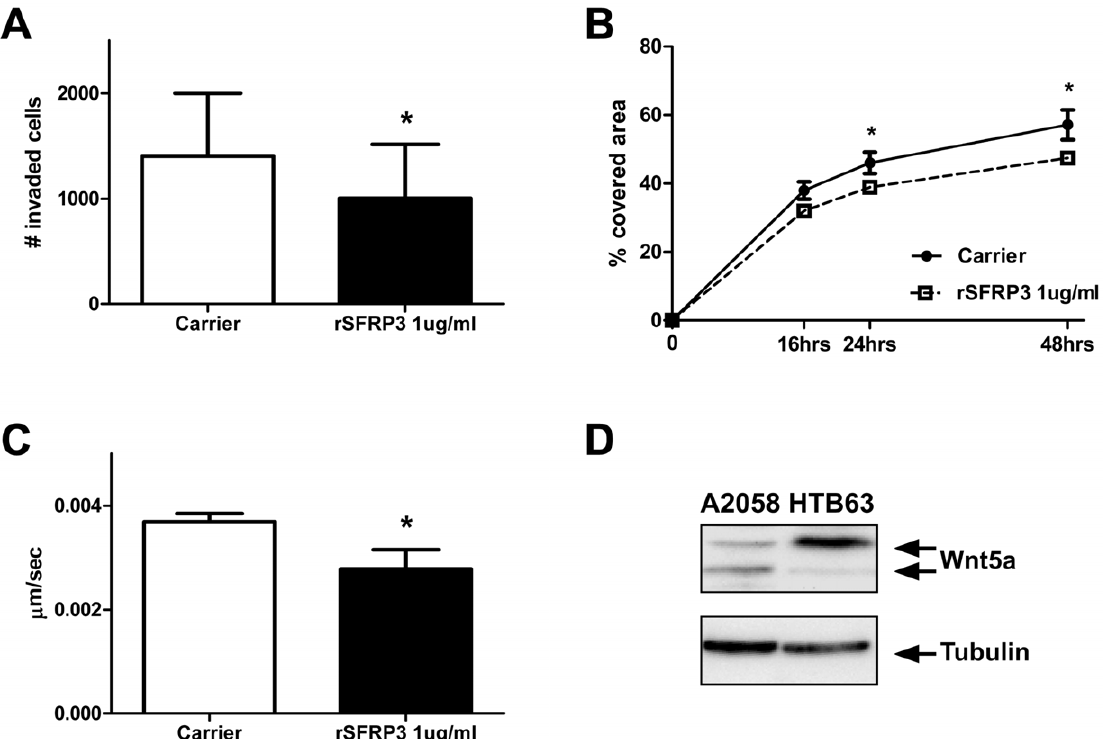
Figure 3. Recombinant SFRP3 decreases migration and invasion of melanoma cells. A , Invasion assay using Matrigel invasion chambers. A2058 cells were resuspended in serum free media and treated in the upper chamber with 1 m g/ml of rSFRP3 or carrier (0.1% BSA in PBS) and allowed to invade for 24 h. The error bars represent SEM, (n=5). B , Wound healing assay. A2058 cells were treated with either 1 m g/ml of rSFRP3 (dashed line, squares) or carrier (full line, circles). Pictures were taken of the scratches at 0, 16, 24 and 48 h. Data is given as percentage of wound area closed at each time point. The error bars represent SEM, (n=5). C , Migration assay, A2058 cells were treated with either 1 m g/ml of rSFRP3 or carrier in serum- free media and migration of non-dividing individual cells was analyzed manually by tracking the speed of cells for 12 h. The error bars represent SEM, (n=5). *=p , 0.05. D , Wnt5a protein expression analysis. Wnt5a expression was analyzed in A2058 cells and HTB63 cells using western blotting.